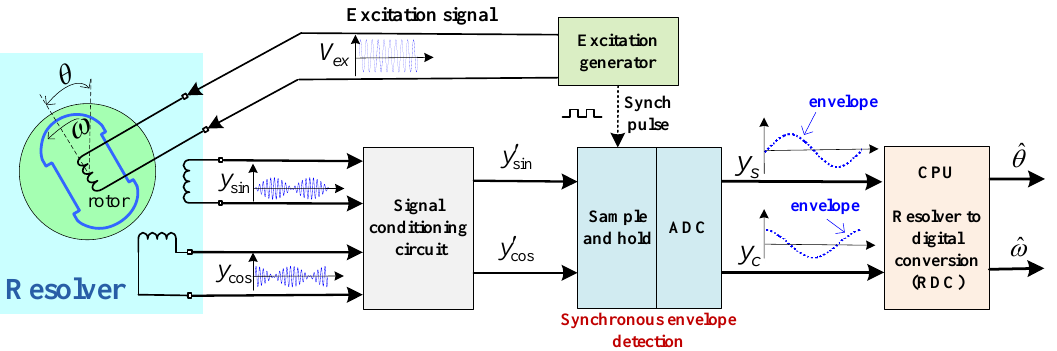
Figure 1. Schematic diagram of resolver and software-based RDC.